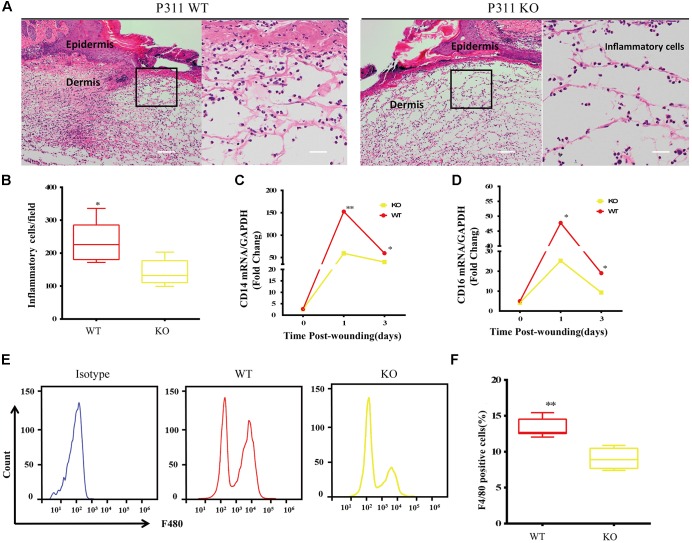
Effect of P311 on the inflammatory response during wound healing. (A) Representative histological analysis of a skin wound by H&E staining on the 3rd day. The area marked by the black box in the left column is enlarged to display the mononuclear inflammatory cells in the right column. Scar bar = 200 μm, 50 μm. (B) Quantitation of mononuclear inflammatory cells in the granulation tissues from H&E-stained wound sections on the 3rd day (n = 3 animals per genotype). CD14 (C) and CD16 (D) mRNA expression in wounds on days 0, 1, and 3 after injury (n = 3 animals per time point and genotype). GAPDH and β-actin are the housekeeping genes used to perform the qPCR analysis. (E) Representative flow cytometry of F4/80. (F) Quantitation data of flow cytometry (n = 3 animals per genotype). Data represented mean ± SD, Student T-test, ∗P < 0.05, ∗∗P < 0.01, P311 KO vs. WT.